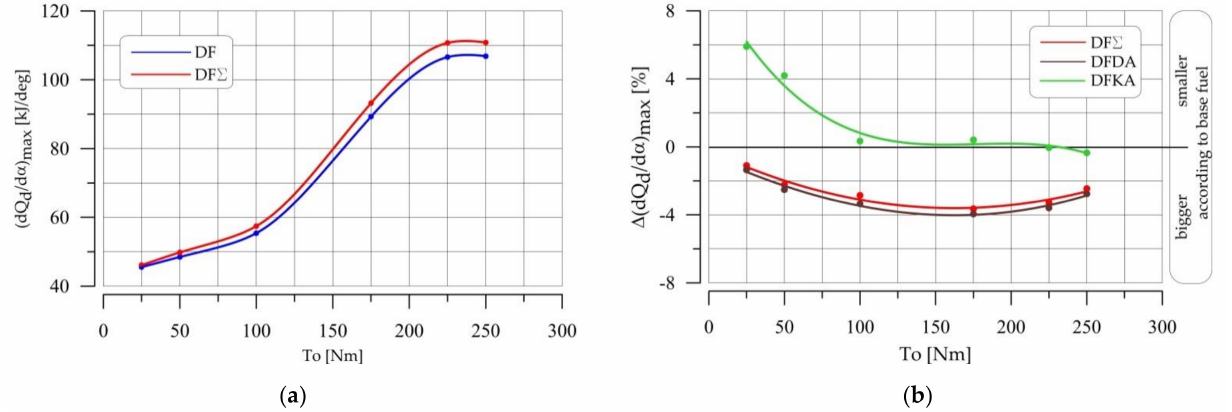
Figure 24. ( a ) Maximum rate of diffusion combustion vs. engine torque; ( b ) Difference of the maximum diffusion combustion rate vs. engine torque in relation to the base